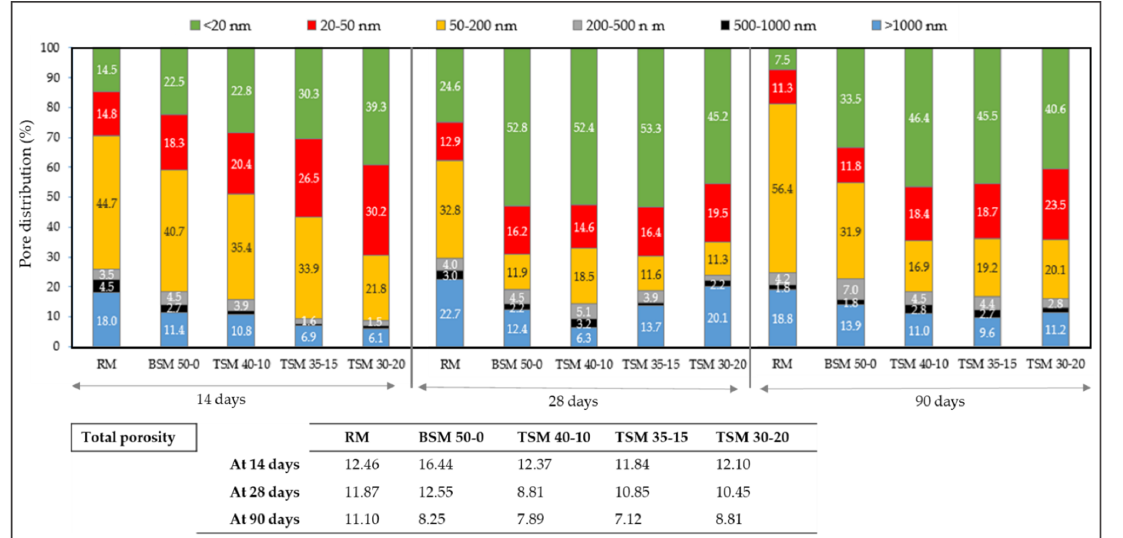
Figure 8. Pore distribution of RM, BSM 50-0, TSM 40-10, TSM 35-15, and TSM 30-20 mortars at 90 days.